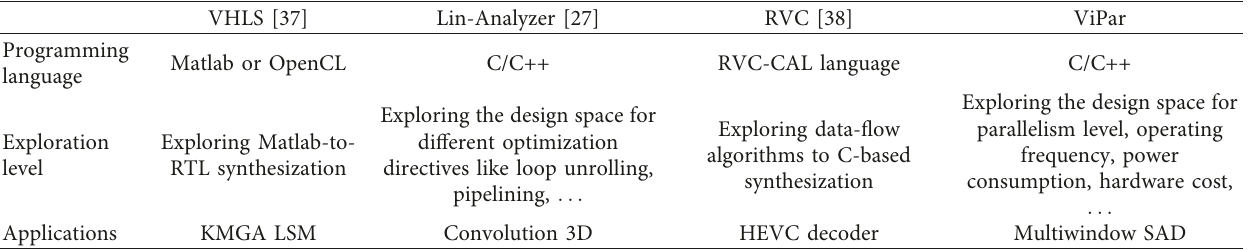
Table 6: Comparing between different high-level tools for video processing application.